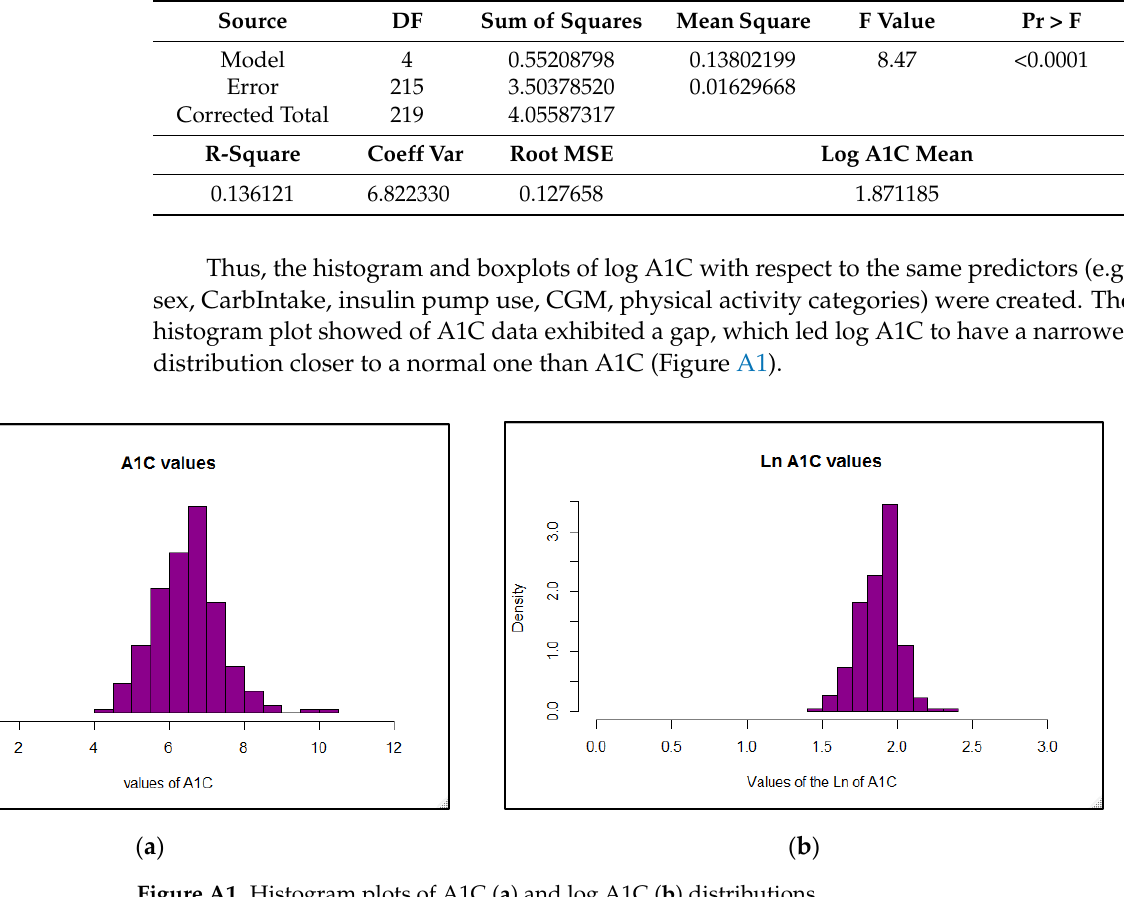
Figure A1. Histogram plots of A1C ( a ) and log A1C ( b )